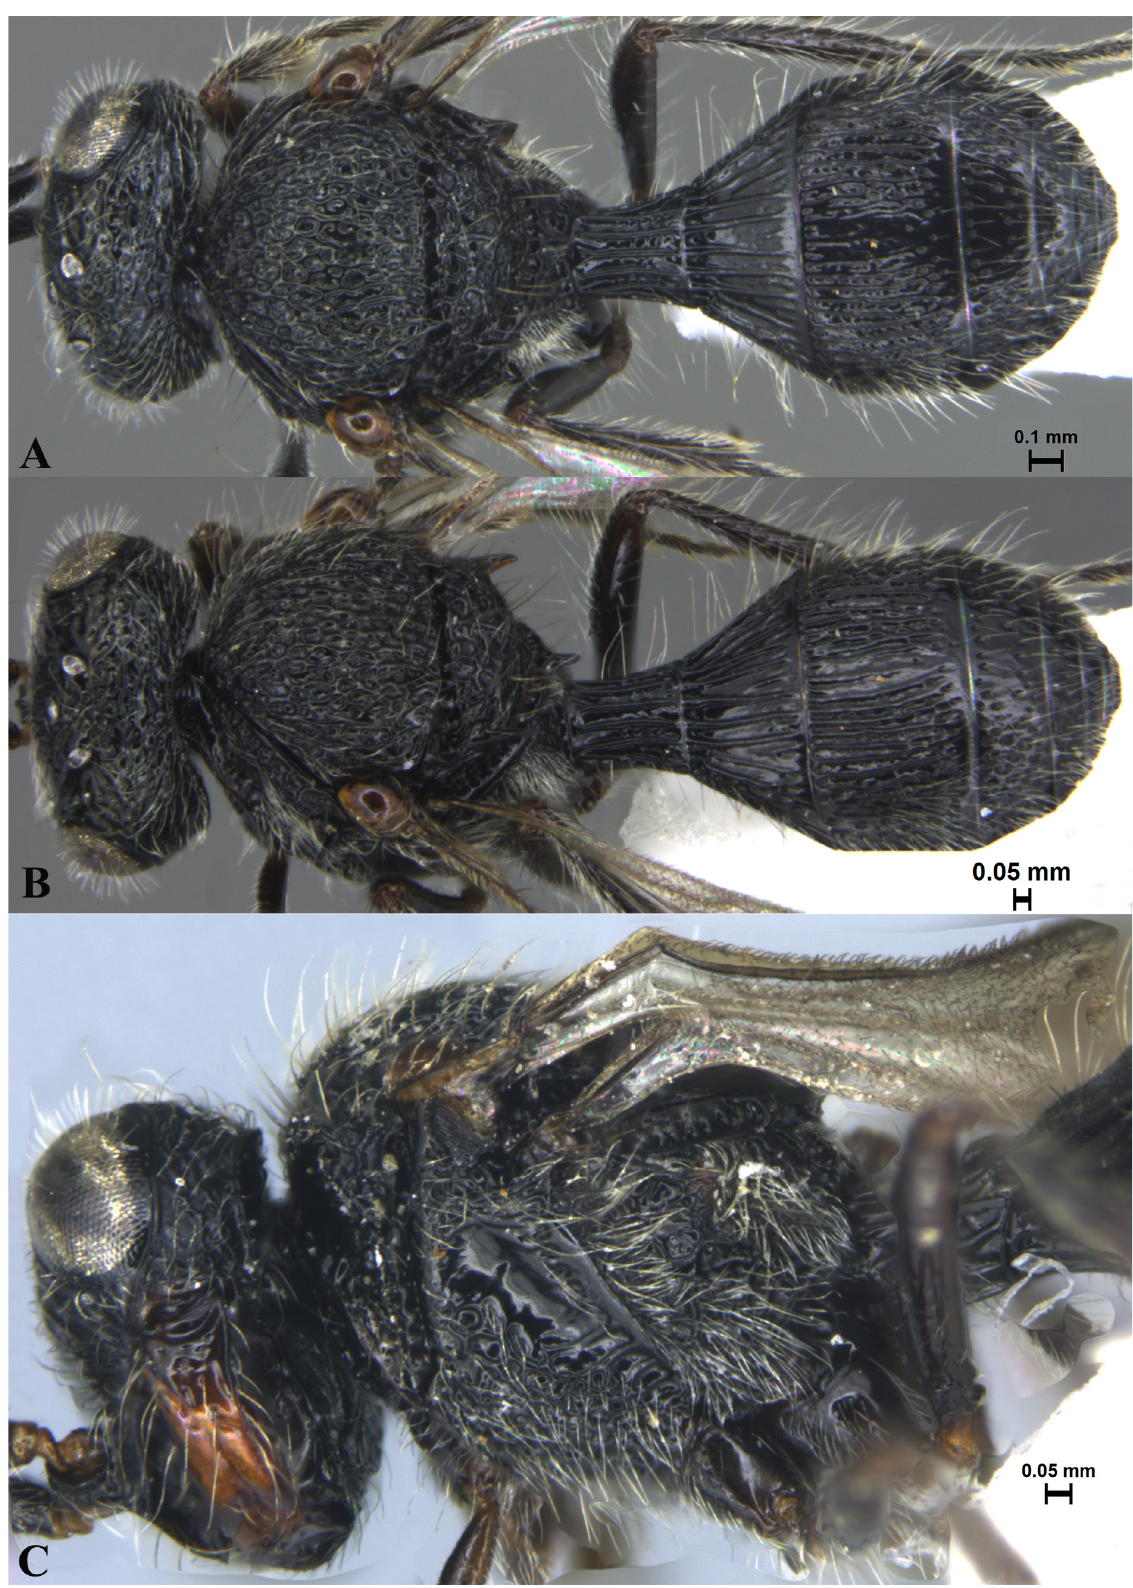
Fig. 25. Odontoscelio sp. 3. ♂ (ICAR-NBAIR P3961). A . Habitus, dorsal view. B . Habitus, showing axillular spines. C . Head and